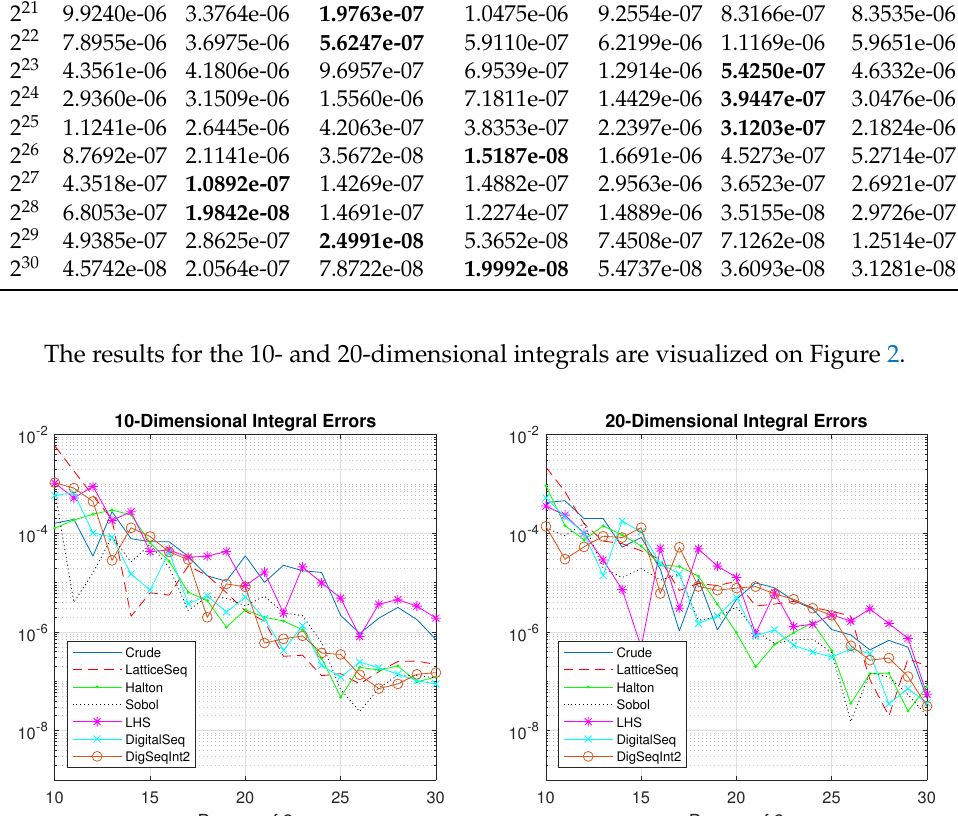
Figure 2. The 10- ( left ) and 20-dimensional ( right ) integral absolute errors. Considering the 30-dimensional integral (Table 3), the scrambled Halton sequence stands out with the 10 smallest errors. For large C , only the interlaced digital sequence produces comparable